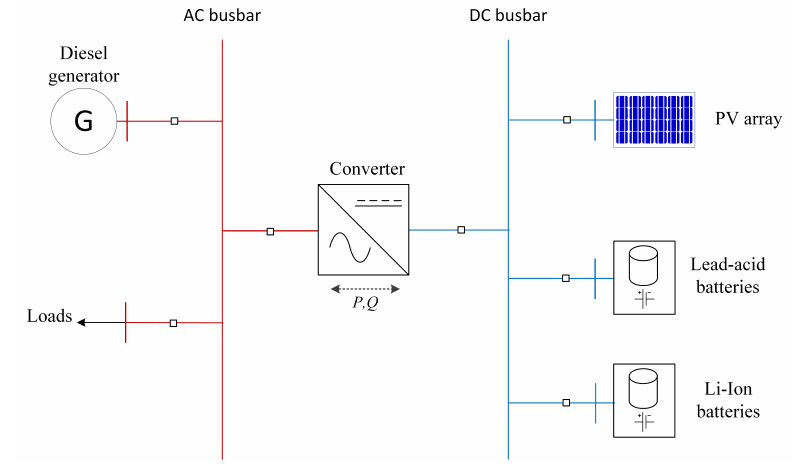
Figure 1. Schematic of microgrid under